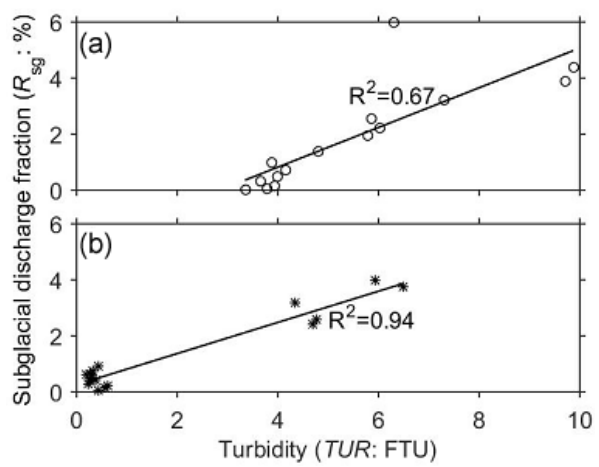
Figure 11. Scatter plots of turbidity and the subglacial discharge fraction at stations (a) 14D1 (data in the meltwater quadrant of Fig. 7c) and (b) 16D3 (data in the meltwater quadrant and that in- cluding the data points at a depth of 15–40m in Fig. 7d). The solid lines represent the linear regression of the